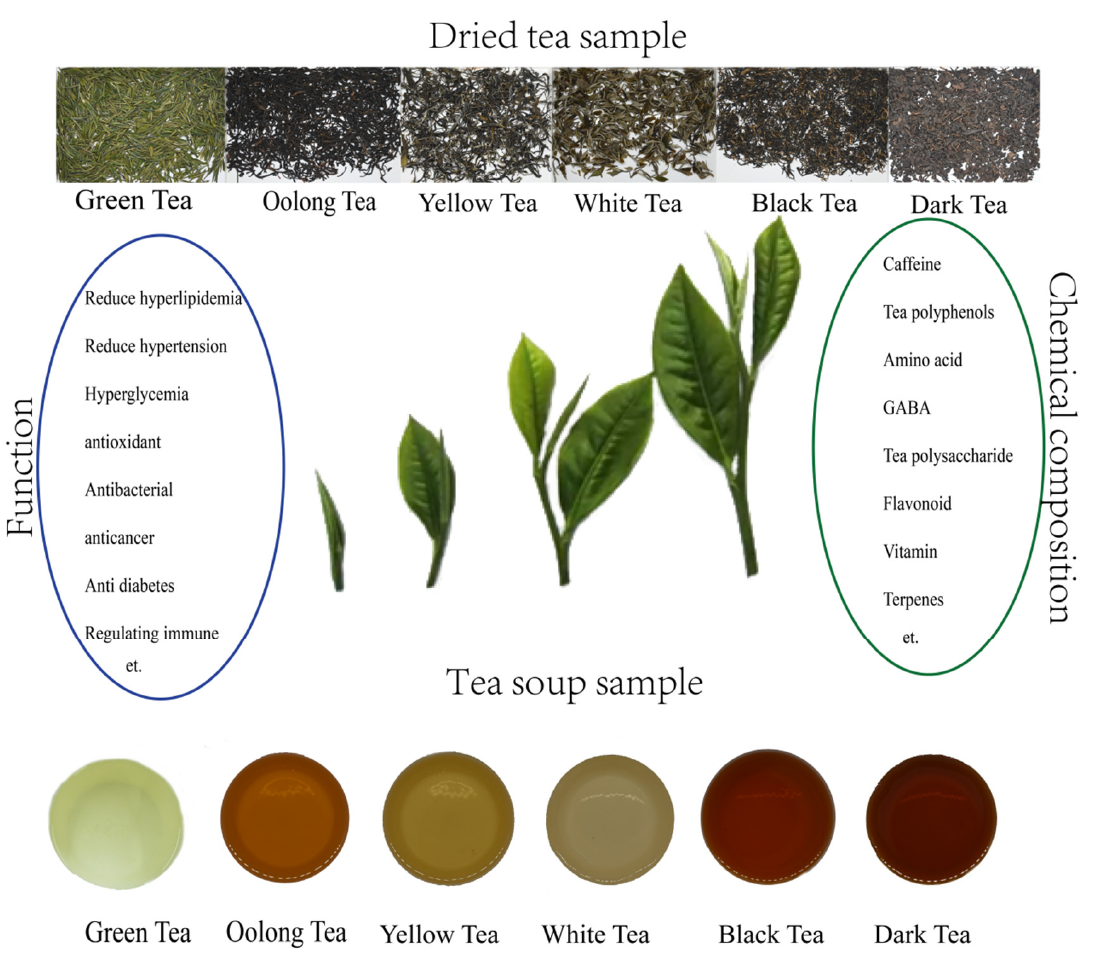
Figure 1. The bioactive composition and application of different types of tea processed by buds and young leaves.